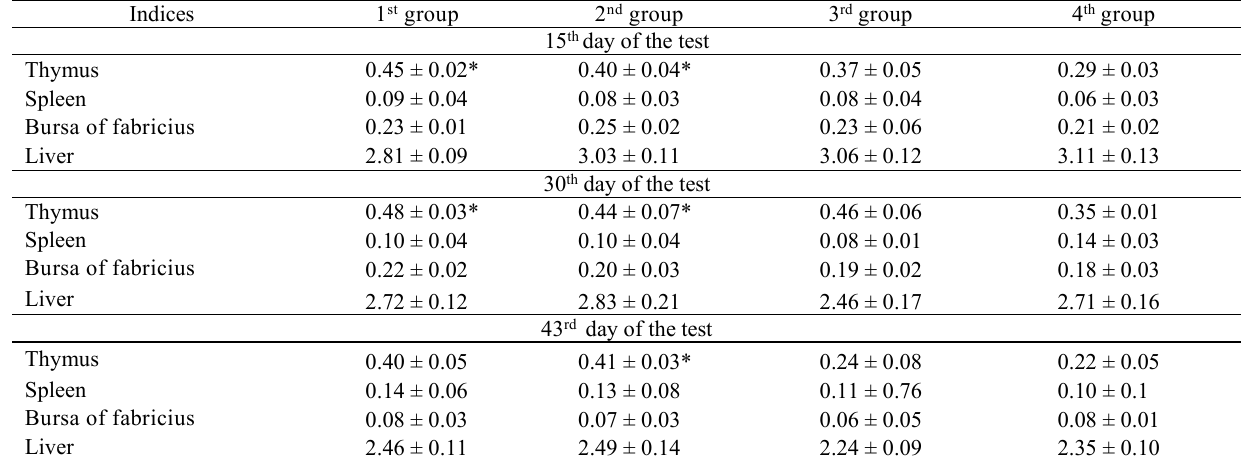
Dynamics of broiler chicken’s mass coefficients of individual internal organs at the application of probiotic feed additives (M ± m, n = 10)